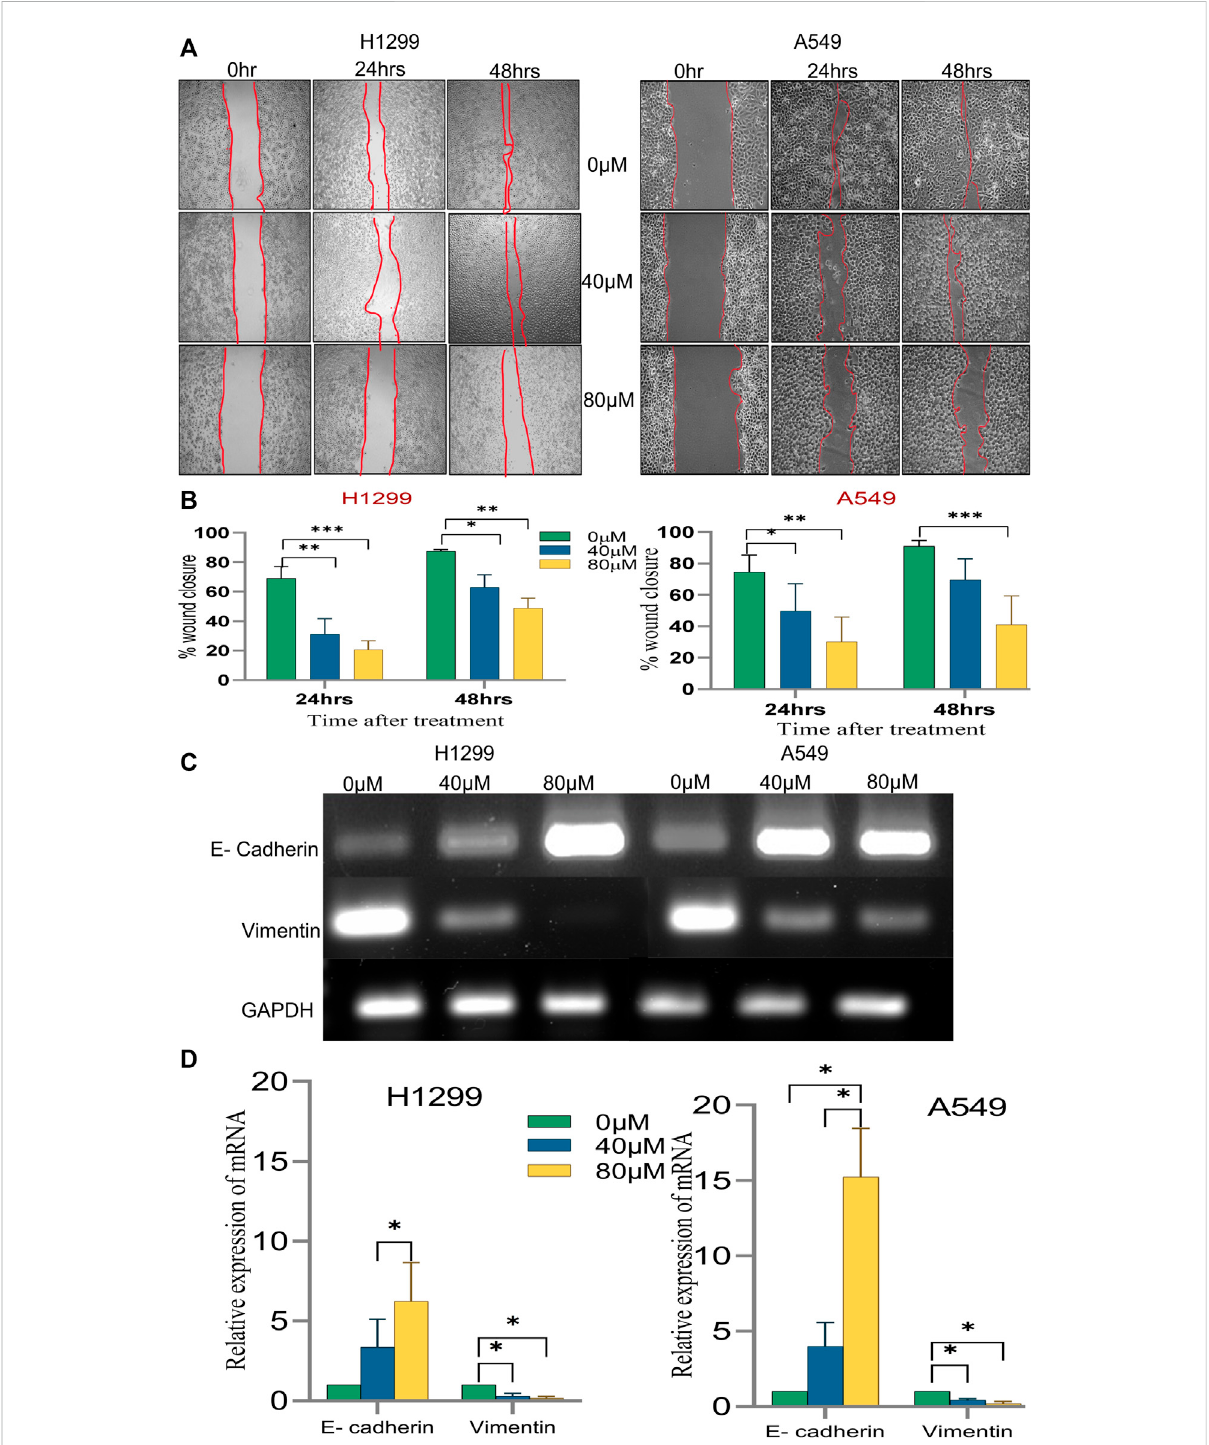
FIGURE 7 Theeffectofdifferentconcentrations of18 α -GAonthemigrationofNSCLCcells. (A) Imagesrepresentingwoundhealingassayattwodifferent time points, the wound area was calculated by ImageJ. (B) % wound closure calculated after treatment with 18 α -GA ( n = 3, mean ± SD), statistical analysis was done by 2-way ANOVA followed by Bonferroni ’ s Post-hoc multiple comparison test, * p < 0.05, ** p < 0.01, *** p < 0.001, **** p < 0.0001 (C) The mRNA expression of related genes after treatment with 18 α -GA by RT-PCR. (D) Graph representing mRNA expression levels of geneswithrespecttoGAPDH,statisticalanalysiswasdoneby2-wayANOVAfollowedbyTukey ’ sPost-hocmultiplecomparisontest,* p < 0.05,** p < 0.01, *** p < 0.001, **** p <